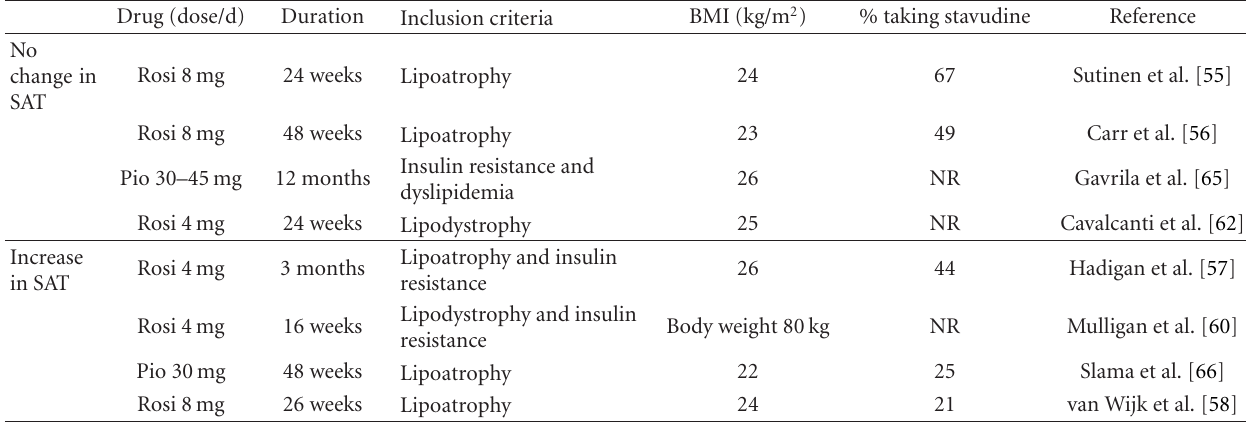
Table 3: Comparison of the baseline characteristics of the thiazolidinedione arms of the studies showing versus not showing an increase in subcutaneous fat mass in HIV-infected HAART-treated patients. HAART = highly active antiretroviral therapy, SAT = subcutaneous adipose tissue, NR = not